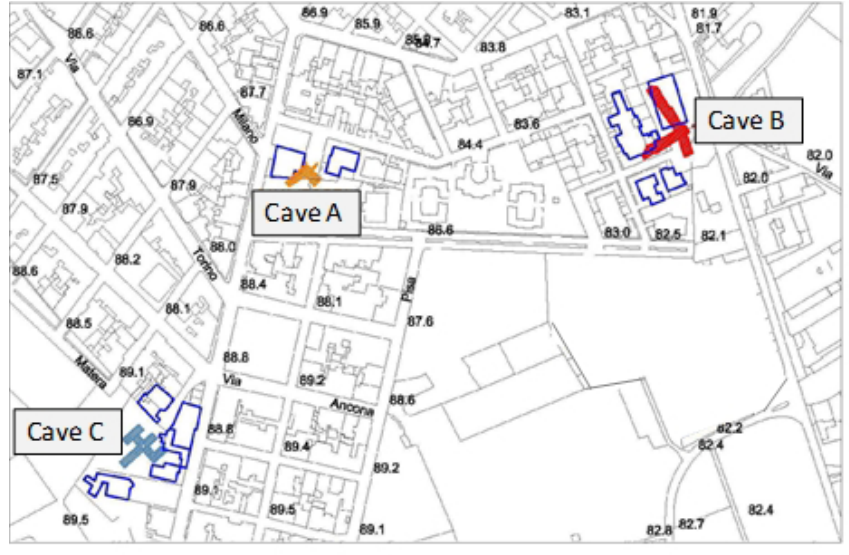
Figure 18. Location of the examined underground quarries at Cutrofiano.